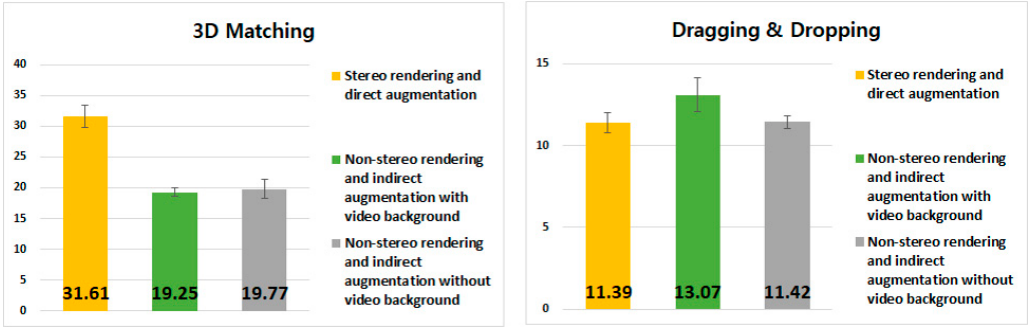
Figure 15. Task completion time (s) of user interaction for visual contexts.